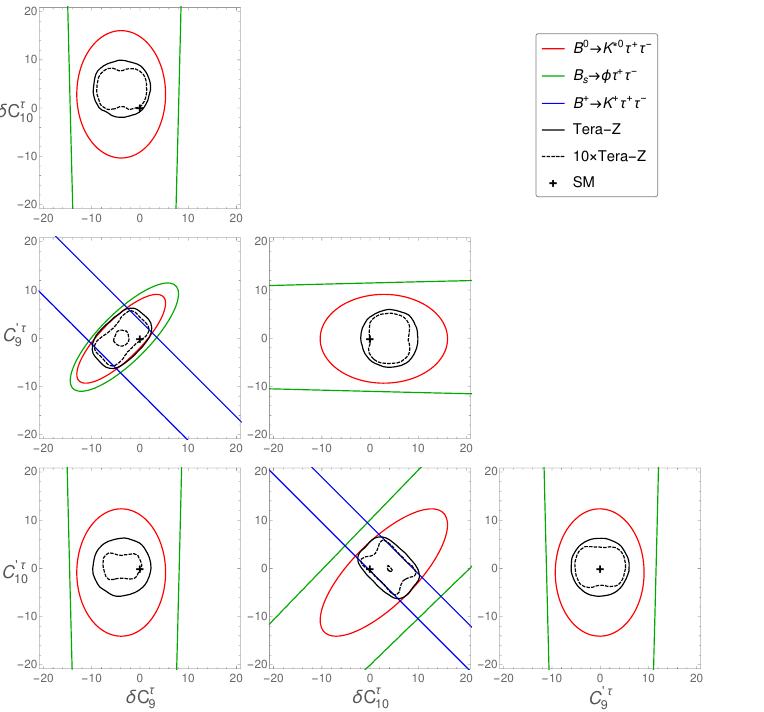
and C 0 τ at the future Z factories, 9 , 10 9 , 10 ∼ (0 . 86 TeV) − 2 2